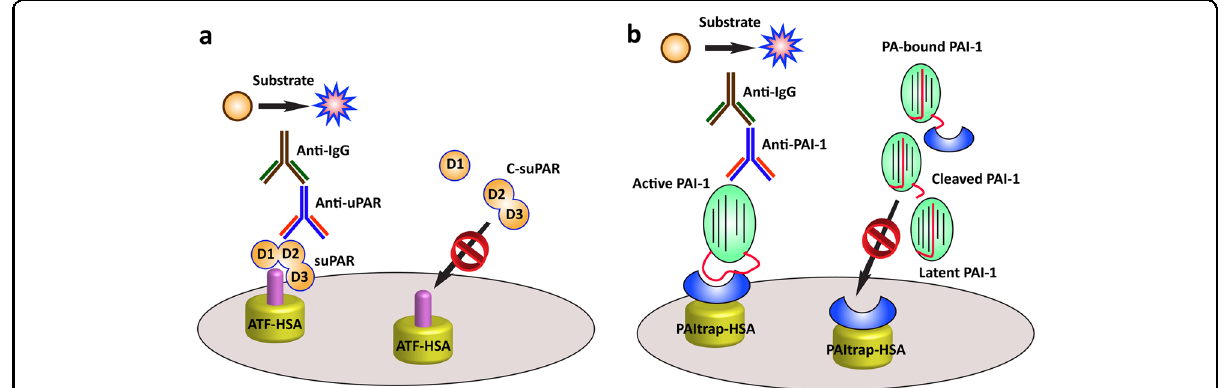
Fig. 3 Mechanistic schemes of ELISA kits for the detection of active suPAR ( a ) and active PAI-1 ( b